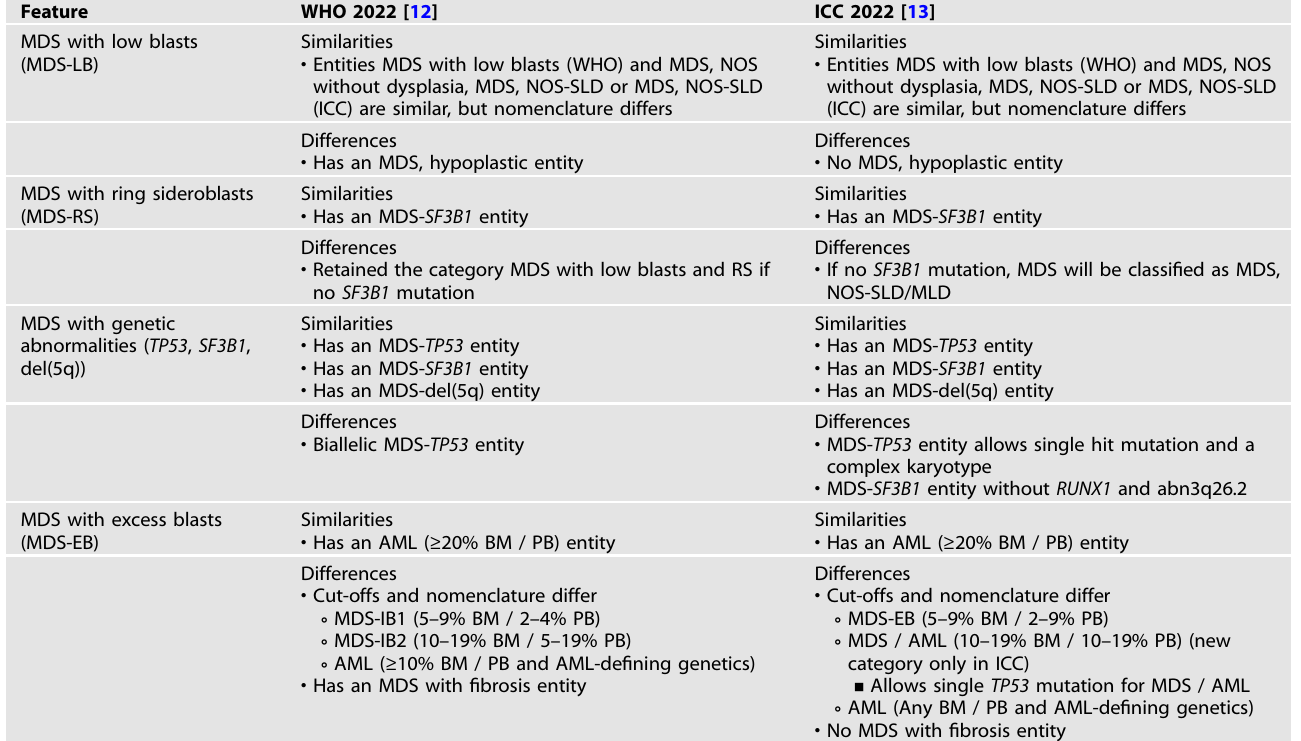
Table 2. Overview of similarities and differences in the WHO 2022 and ICC 2022 MDS criteria. Feature WHO 2022 [12] ICC 2022 [13] MDS with low blasts Similarities (cid:129) Entities MDS with low blasts (WHO) and MDS, NOS (MDS-LB) without dysplasia, MDS, NOS-SLD or MDS, NOS-SLD